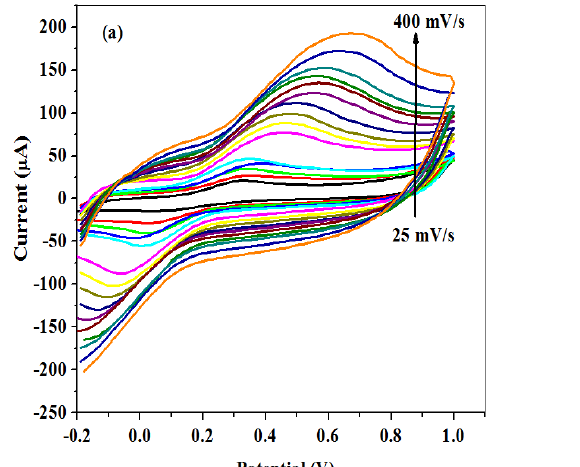
Figure 12. ( a ) Square wave voltammograms recorded at SPCE-Fe 3 O 4 /SPEEK electrode over dopamine concentrations range from 5 to 50 μ M; ( b ) linear graph of reduction peak currents versus DA concentrations prepared in 0.1 M of PBS (pH 7.4).